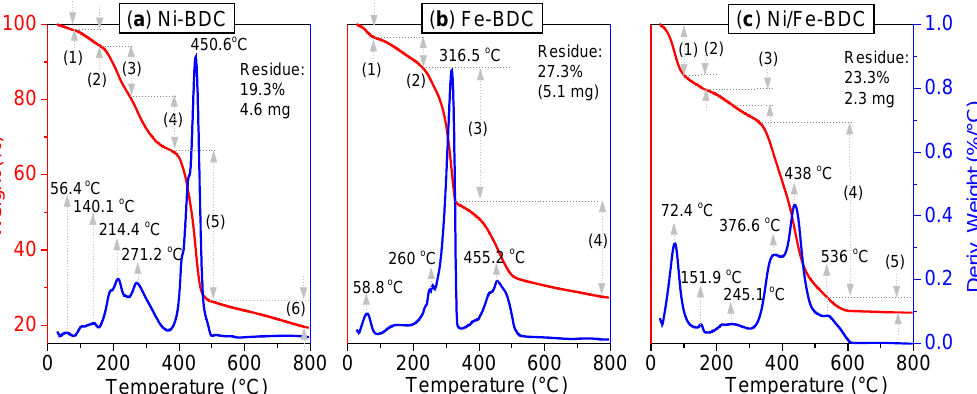
Figure 2. TGA analysis of the Ni-1,4-Benzenedicarboxylic (Ni-BDC) (a), Fe-1,4-Benzenedicarboxylic (Fe-BDC) (b), and Fe2Ni-1,4-Benzenedicarboxylic (Fe2Ni-BDC) (c).